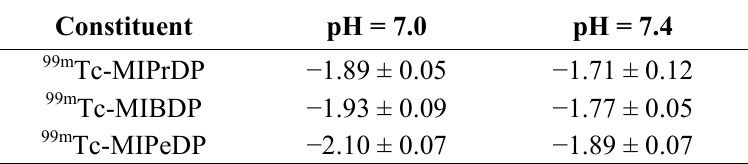
Table 1. Octanol-water partition